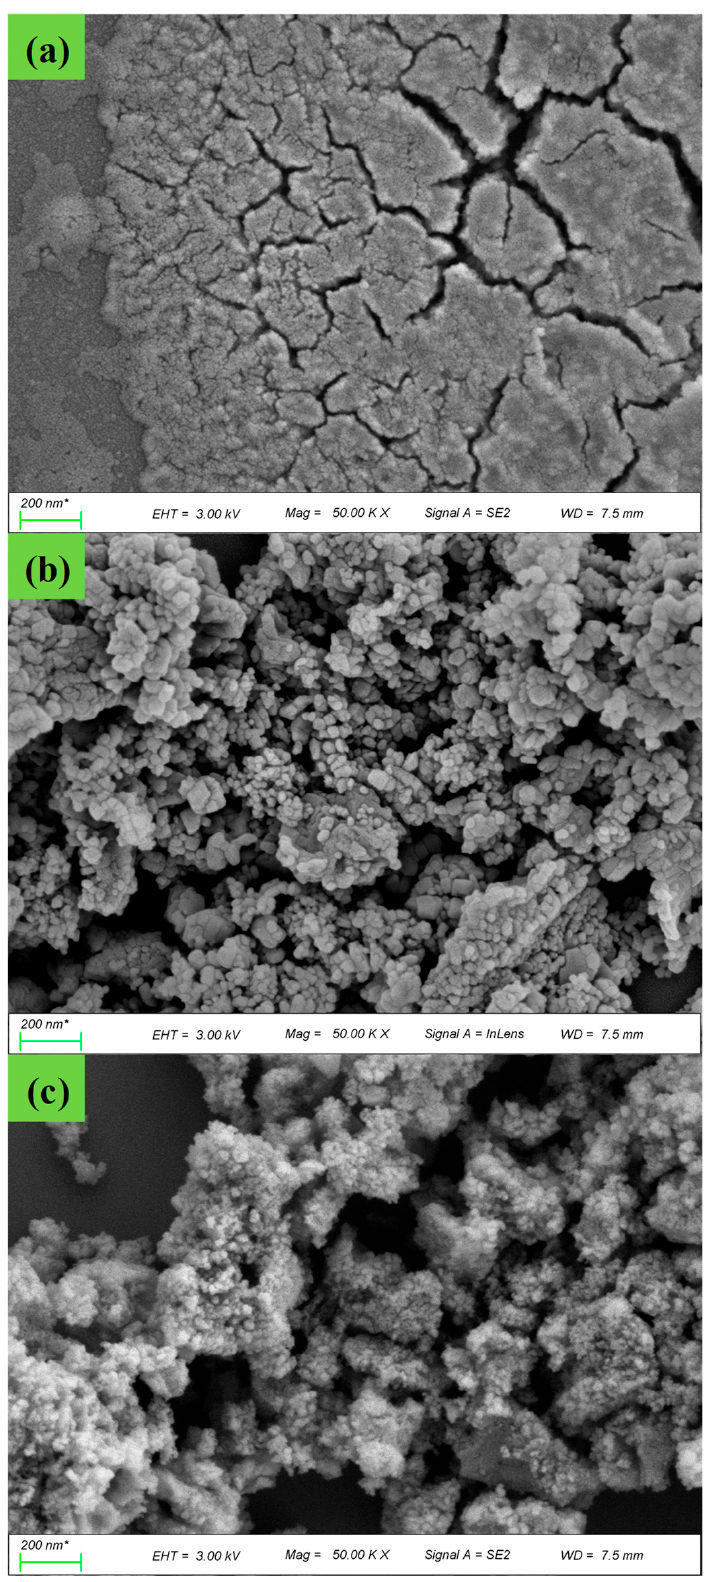
Figure 3. SEM images of HPW ( a ), Mn ( b ), and Mn-HPW 0.02 ( c ).